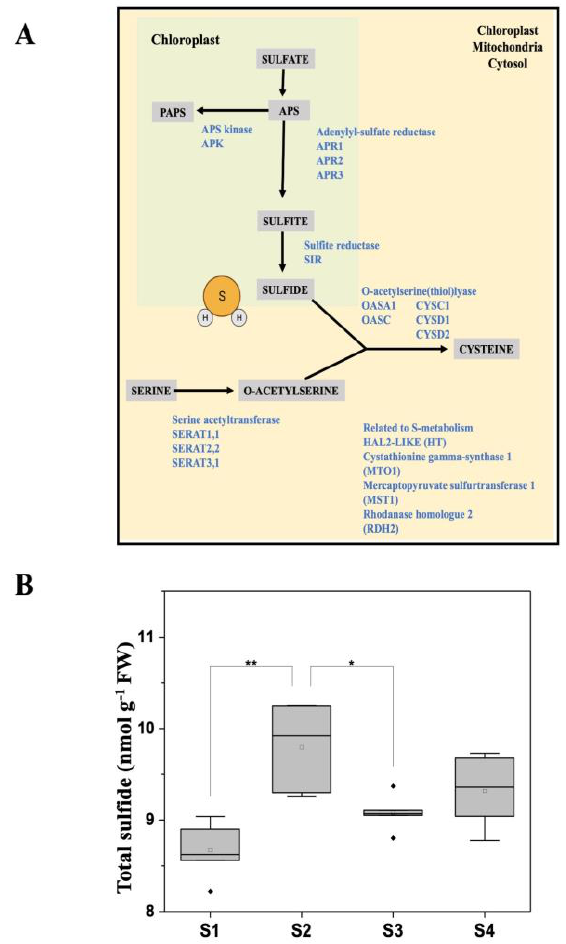
Figure 4. ( A ) Graphical representation of the overrepresented enzymes involved in the sulfate as- similation and cysteine biosynthesis pathways identified in cluster 1. The green panel corresponds to chloroplastic located processes and the yellow corresponds to enzymes that can be located either in the chloroplast, the mitochondria, or the cytosol compartments. APK, APS kinase; APR, APS reductase; APS, adenosine 5_-phosphosulfate; OAS/CYS, O-acetylserine(thiol)lyase; PAPS, 3_-phosphoadenosine 5_-phosphosulfate; SERAT, serine acetyltransferase; SiR, sulfite reductase. ( B ) Total sulfide content in leaf tissue. Sulfide concentration was quantified after derivation and HPLC-MS analysis in independent leaf extracts ( n = 5). Asterisk shows significant differences, ** p < 0.01, * p < 0.05, as indicated after ANOVA and post hoc Tukey’s HSD test.